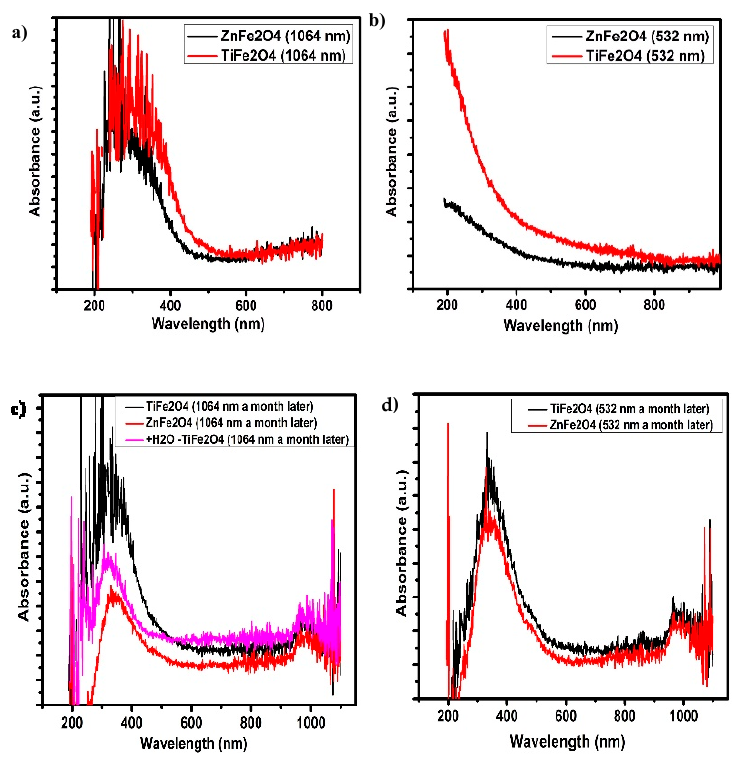
Figure 2. UV-Vis absorbance spectra of metal oxide nanoparticles (MONPs) produced with laser ablation technique in water at ( a , c ) 1064 and ( b , d ) 532 nm wavelengths.